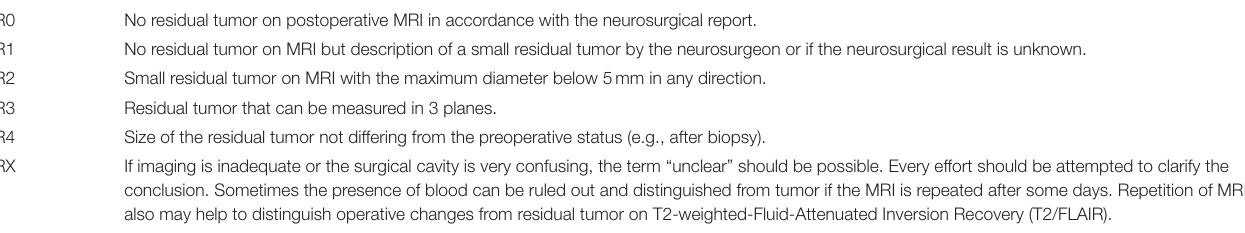
TABLE 1 | Refined SIOP EPII definitions of residual tumors (specific criteria that apply only for early postoperative MRI).